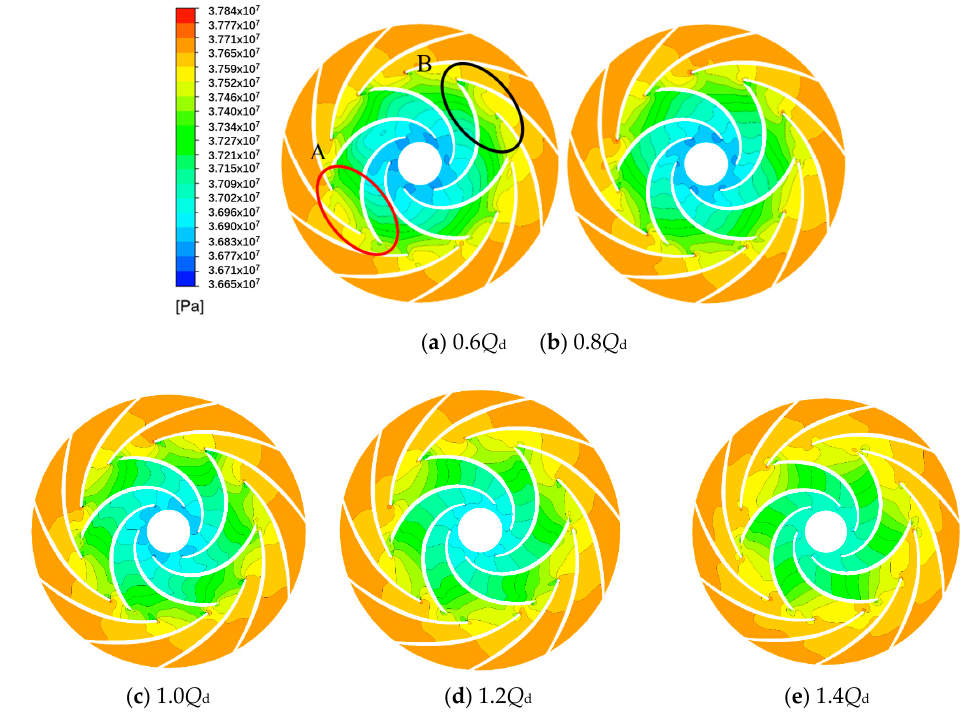
Figure 10. Pressure Distribution in Impeller and Guide Vane.